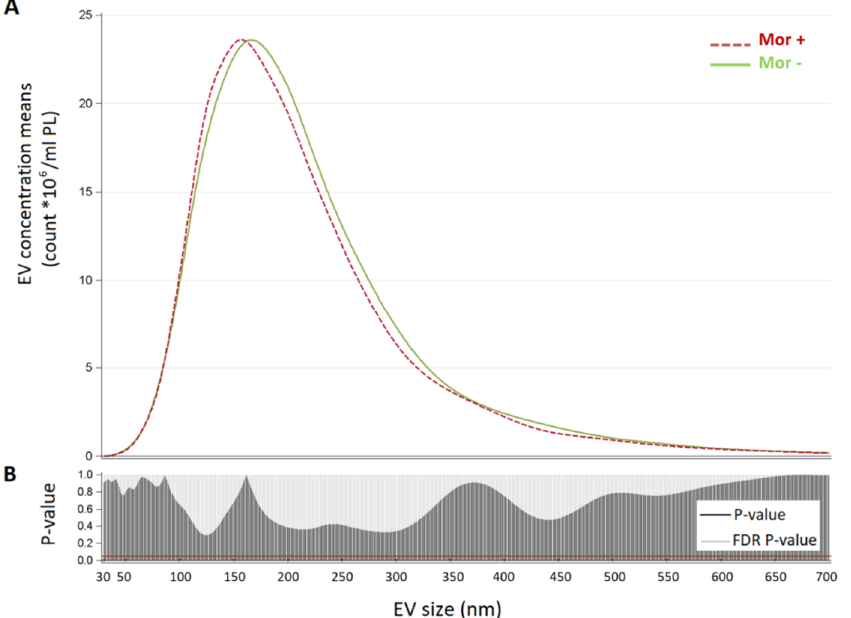
Figure 2. Extracellular vesicle (EV) size distribution in the Mor− and Mor+ groups. Panel ( A ): * Reported geometric means were adjusted for age, sex, BMI, and smoking habits. Plots showing for each group (Mor− and Mor+) the distribution of mean vesicle concentrations for each size. Panel ( B ): vertical bar charts represent FDR and p -value for each size comparison; the red line indicates p -value = 0.05.